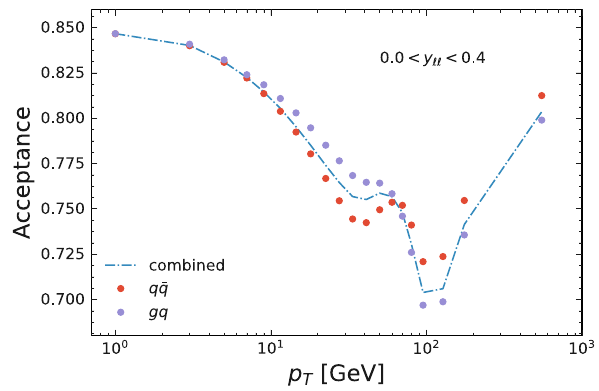
Fig. 4 Fiducial acceptance calculated for q ¯ q and qg contributions for 0 < y (cid:4)(cid:4) < 0 . 4